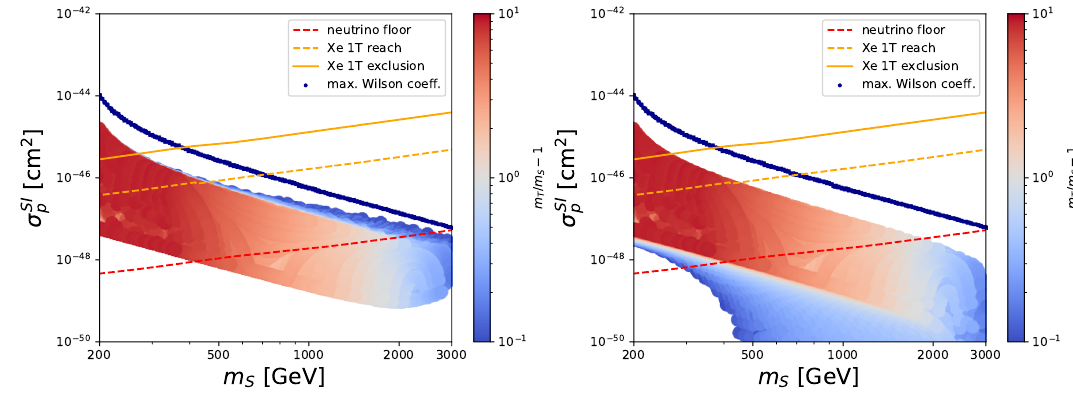
Figure 4 . The DM-proton cross section σ p for positive (left) and negative (right) C/ Λ values, and for the maximum value of the Yukawa coupling ˜ y t so that there exists a combination of the other model parameters that gives the correct relic density. The r = m T /m S − 1 value (shown through the red-and-blue colour scheme) is enforced to lie in a [0.1,9] interval and is derived from the value of the other model parameters and the relic density. The bottom limit of 0.1 ensures that we are in a well-understood regime of spectrum compression, and the upper limit is chosen such that the vector-like resonance and the scalar DM are not too different in mass. Additionally, we display the cross section obtained through use of the maximum possible Wilson coefficient | C | , which is displayed in dark blue. In those scenarios the dependence of the relic density on ˜ y t is negligible with respect to the contribution from the SStt interactions. Finally, the red dashed line represents the neutrino floor [30], the orange dashed line indicates the XENON 1T reach [31], and the red solid line shows the 90% confidence exclusion of the XENON 1T experiment